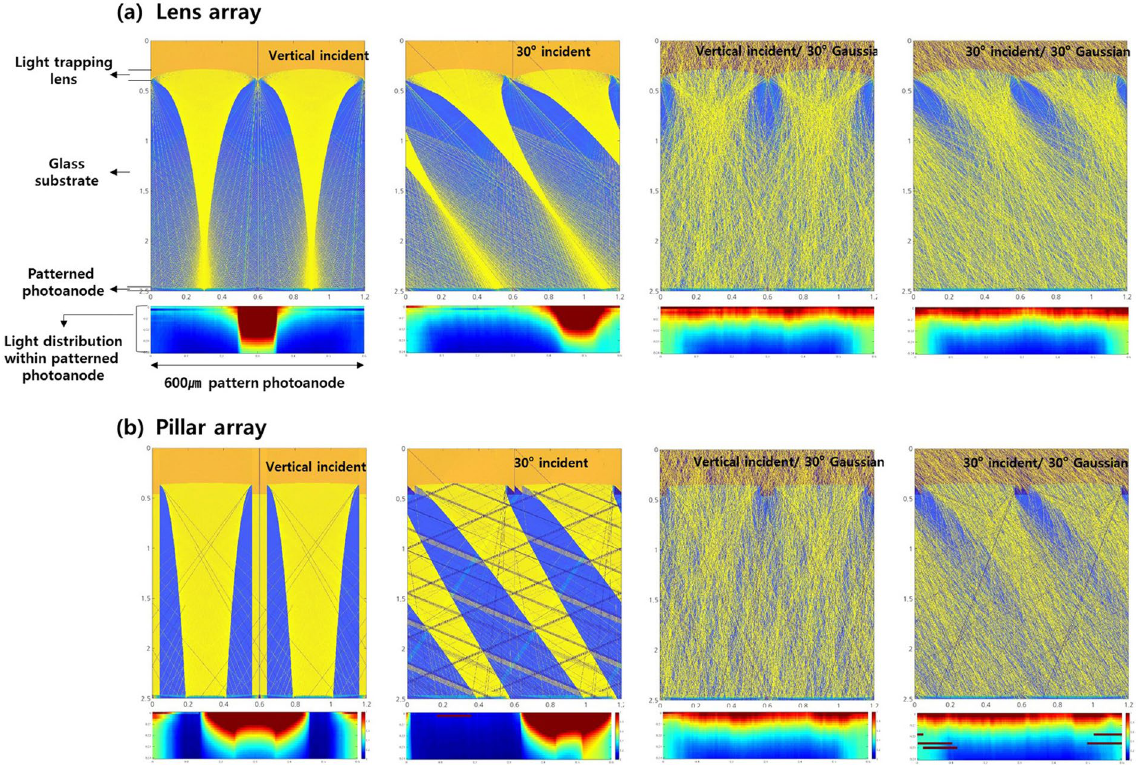
Figure 4. Light distribution and intensity within patterned photoanodes incorporating a ( a ) lens array and ( b ) pillar-shaped lens array, according to two-dimensional ray-tracing analyses. The labels ‘vertical incident’ and ‘30 degree incident’ indicate that the incident beam was vertical or at an angle of 30 degrees to the cell. The angle of incidence of each photon following a Gaussian distribution centered on the vertical and ranging up to 30 degrees is labeled ‘vertical incident/30 degree Gaussian’; that centered at 30 degrees with a range of 30 degrees is labeled ‘30 degree incident/30 degree